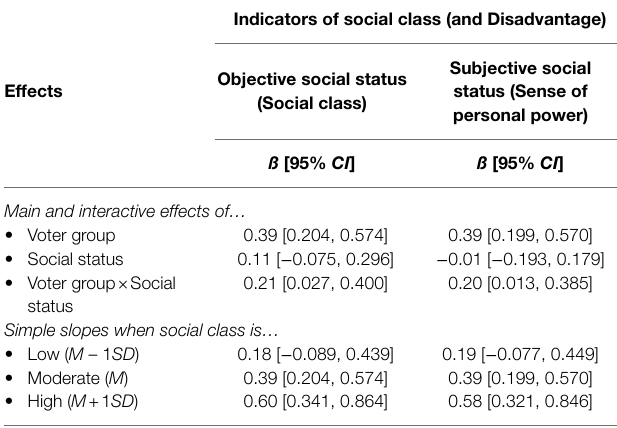
TABLE 5 | The moderating role of Objective and Subjective Social Status Indicators on the Effect of Voter Group on System Justification Motive.